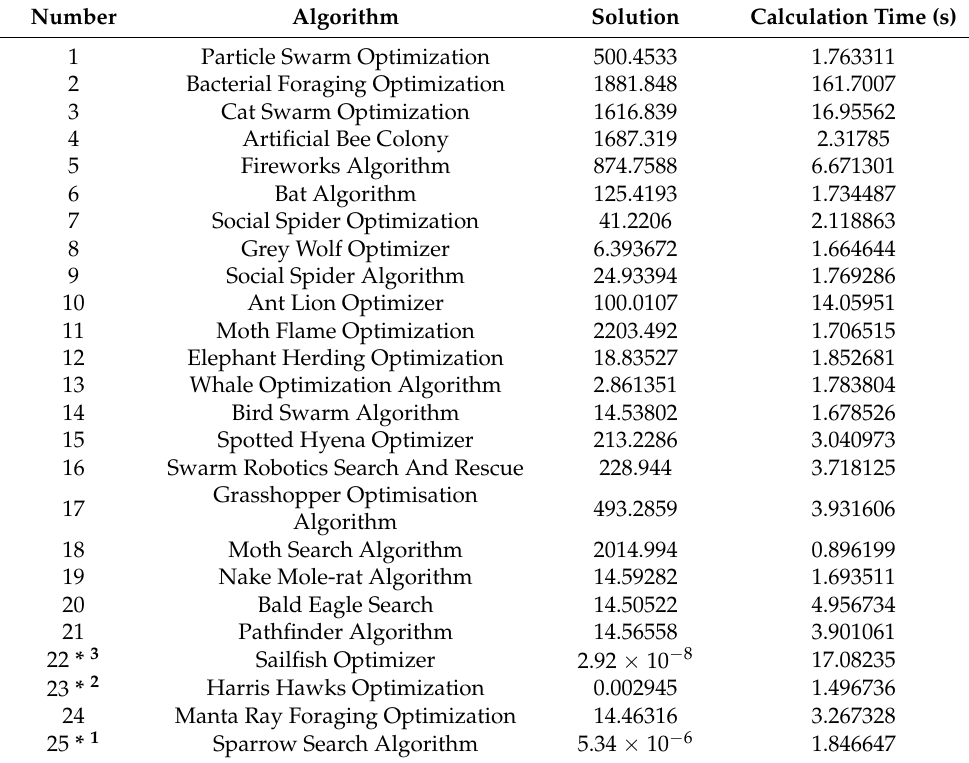
Table 2. The performance of popular swarm-based